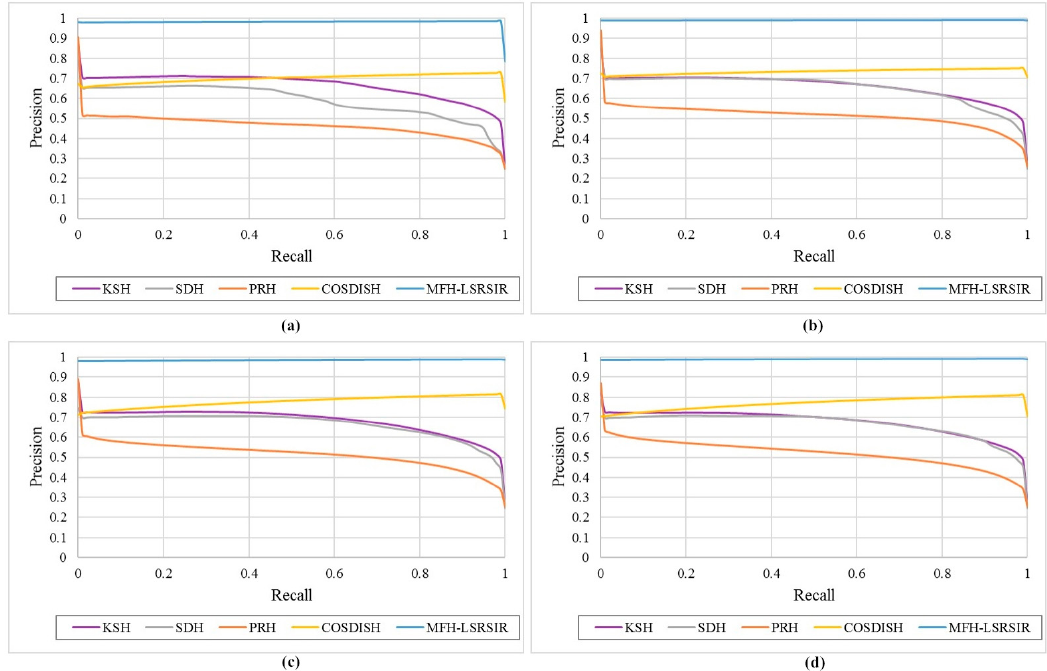
Figure 8. Compared precision-recall curves between different hashing methods with varied hash code lengths on the SAT-6 datasets: ( a ) 8 bits; ( b ) 16 bits; ( c ) 32 bits; and, ( d ) 64 bits.